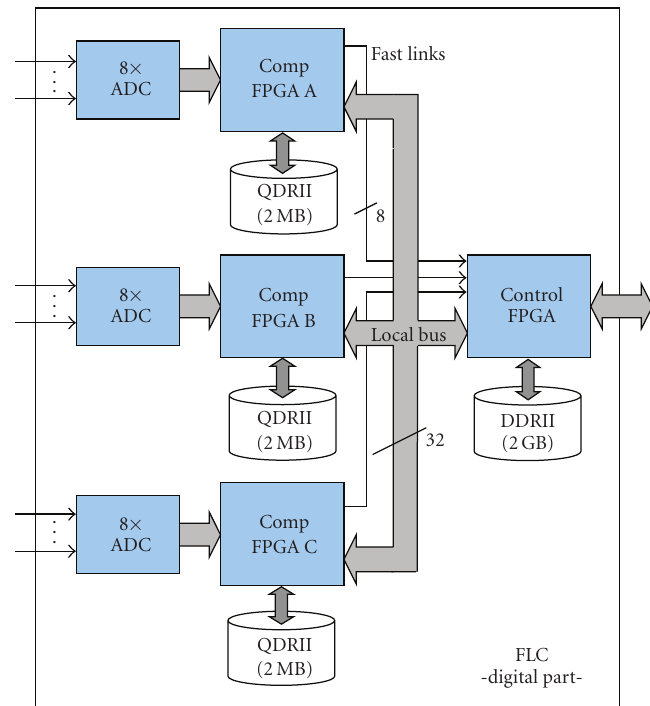
Figure 3: Block diagram of the digital part of an FLC in the 3D USCT DAQ system. It is equipped with four Altera Cyclone II FPGAs, one for local control (control FPGA, Cntr FPGA) and three for signal acquisition (computing FPGAs, Comp FPGA). Each Comp FPGA is fed by an 8-fold ADC and is attached to a 2MB QDR static RAM module. The Cntrl FPGA is attached to a 2GB DDRII dynamic RAM. Communication on each board is either possible by the slower local bus (Local Bus, 80MB/s) or by fast data links (Fast Link, 240MB/s).